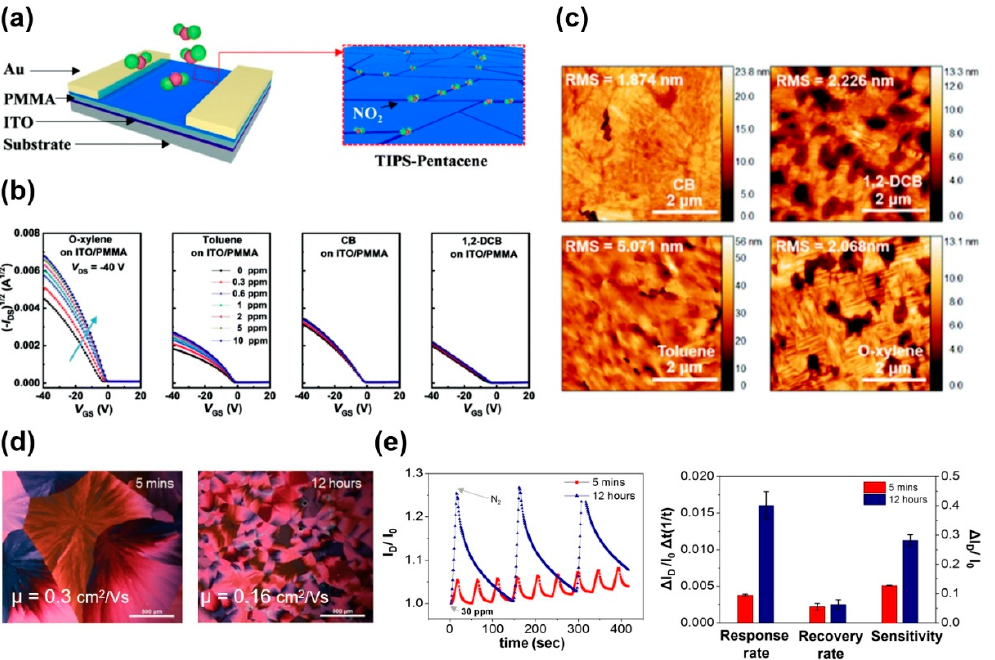
Figure 4. ( a ) The device structure and sensing mechanism of TIPS-pentacene sensors showing diffusion of NO 2 through the grain boundaries, ( b ) the change in the transfer curves for the o-xylene, toluene, chlorobenzene (CB), and 1,2-dichlorobenzene (1,2-DCB)-processed TIPS-pentacene FETs upon NO 2 exposure at various concentrations, ( c ) atomic force microscopy images of TIPS-pentacene films processed with different solvents [75]. Copyright 2019 Royal Society of Chemistry. ( d ) Polarized optical microscopy images of the solvent vapor annealed TES-ADT films whose solutions were mixed for 5 min or 12 h, and ( e ) response curves and summarized performance of TES-ADT FETs upon sequential NO 2 and N 2 exposure [76]. Copyright 2017 Wiley.